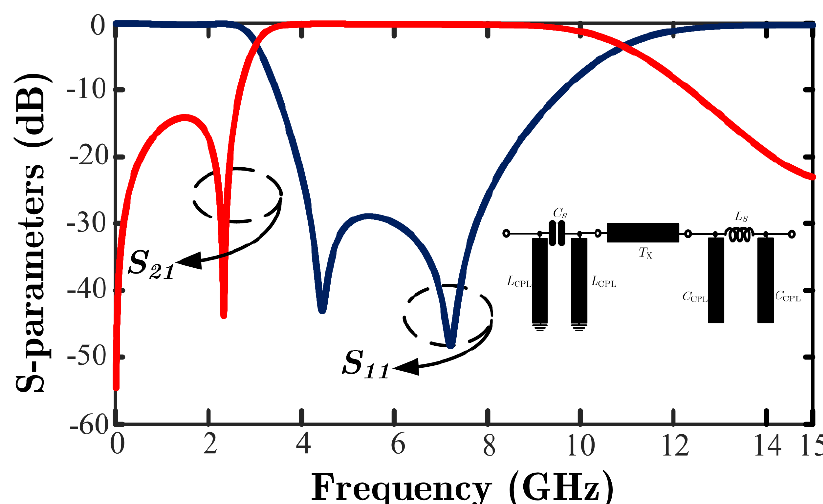
Figure 5. The results of the UWB-BPF without compensated inductors using computer simulations.